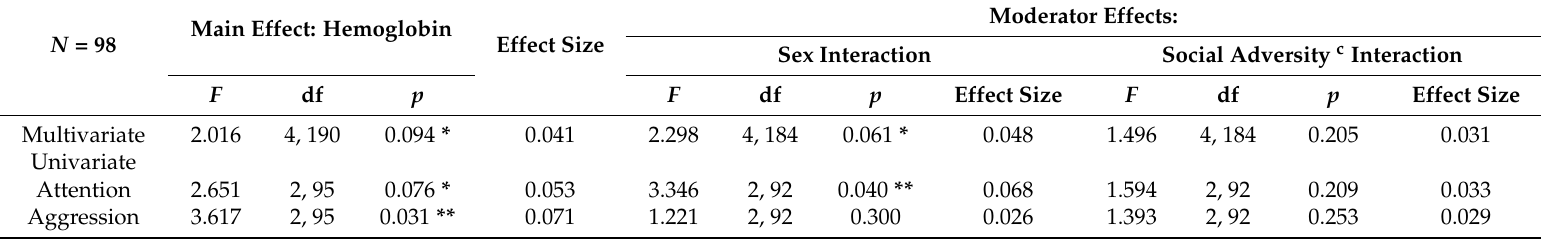
Table 3. Univariate and multivariate analysis of variance a of the effect of hemoglobin levels b at age 4 on externalizing behavior at age